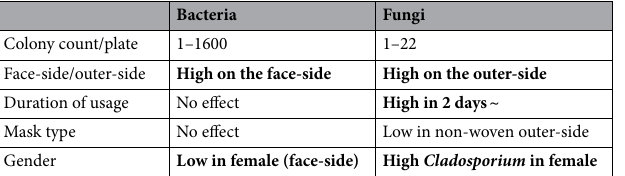
Table 1. Factors associated with microbial colony counts on face masks. Boldface indicates a significant difference ( P < 0.05).